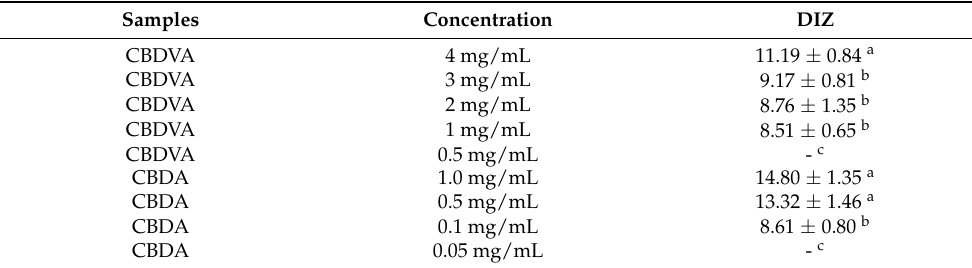
Table 3. The DIZ of E. coli under different concentrations of CBDVA and CBDA (mm).